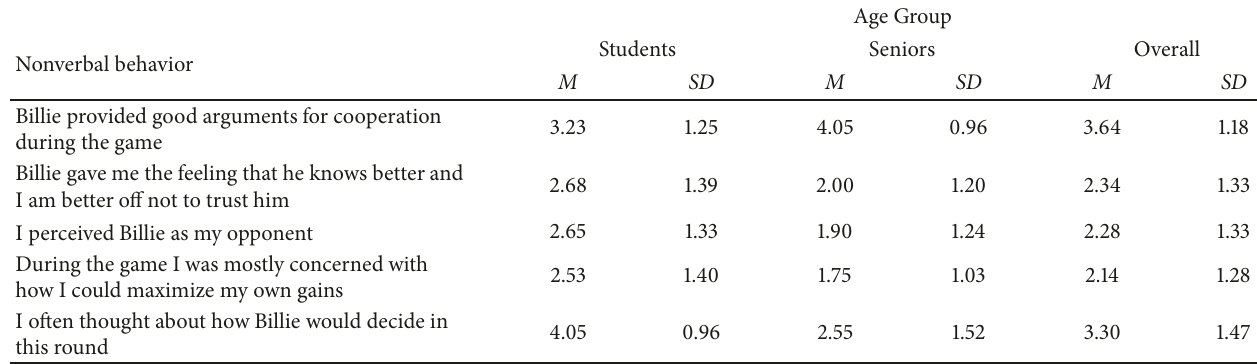
Table 3: Means of age group’s game